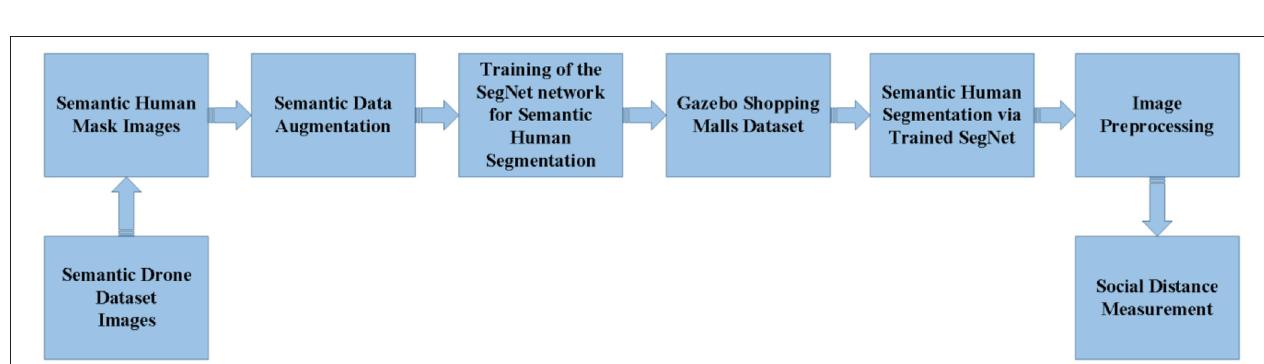
FIGURE 6 | The prediction made by KF in frames where people cannot be detected by HOG-SVM (In cases where human detection cannot be made, predictions made by KF cannot be corrected with the measurement value. This causes erroneous estimations).